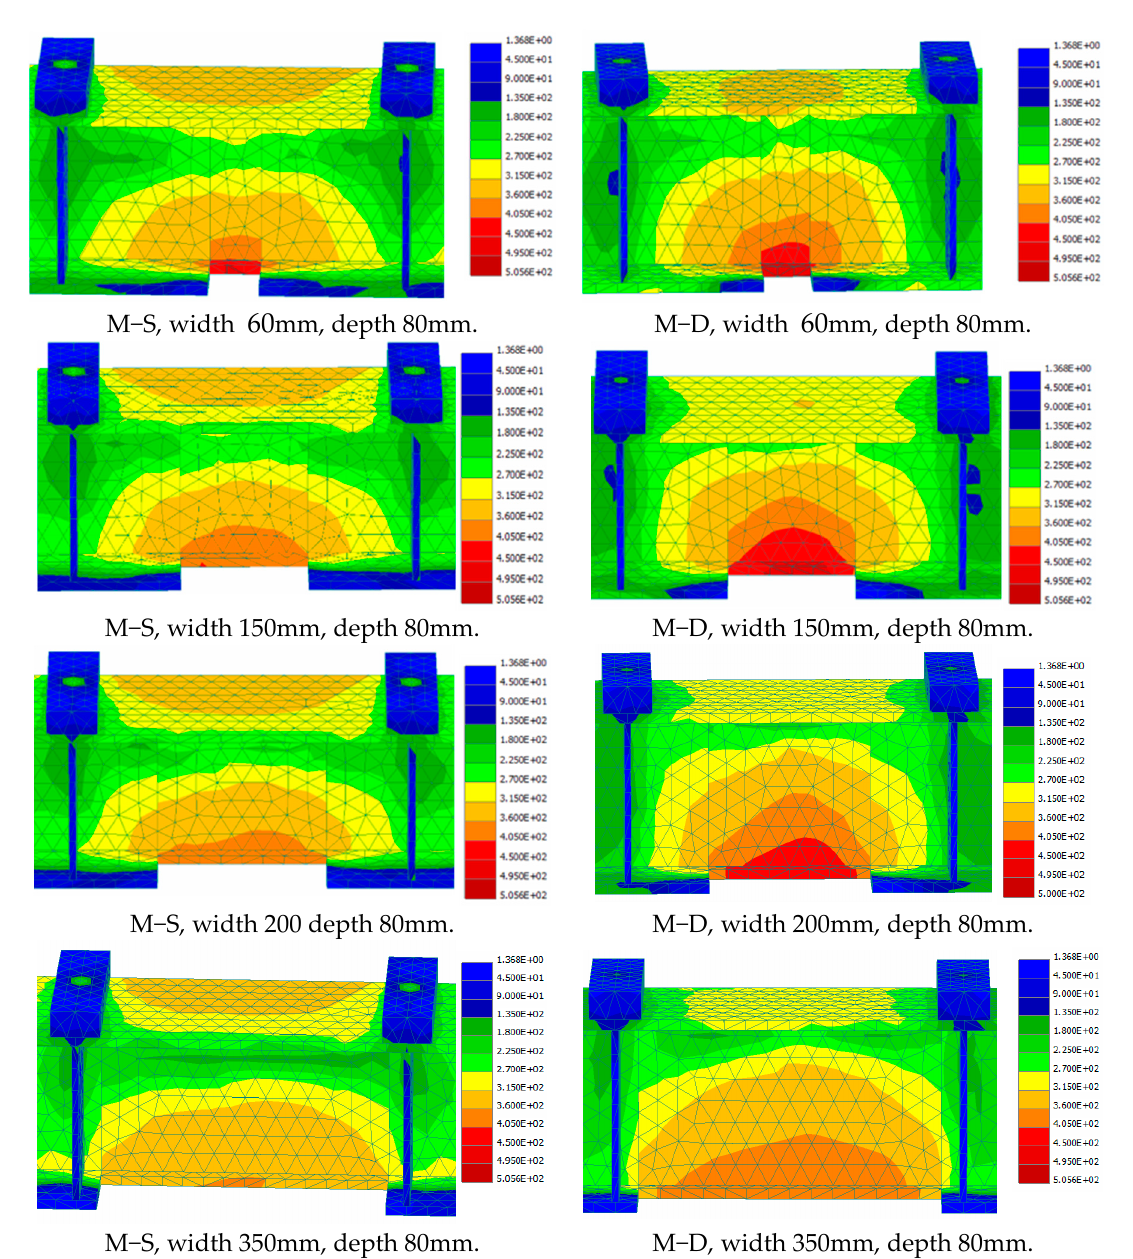
Figure 12. Stress distribution with the middle third segment of the beams.